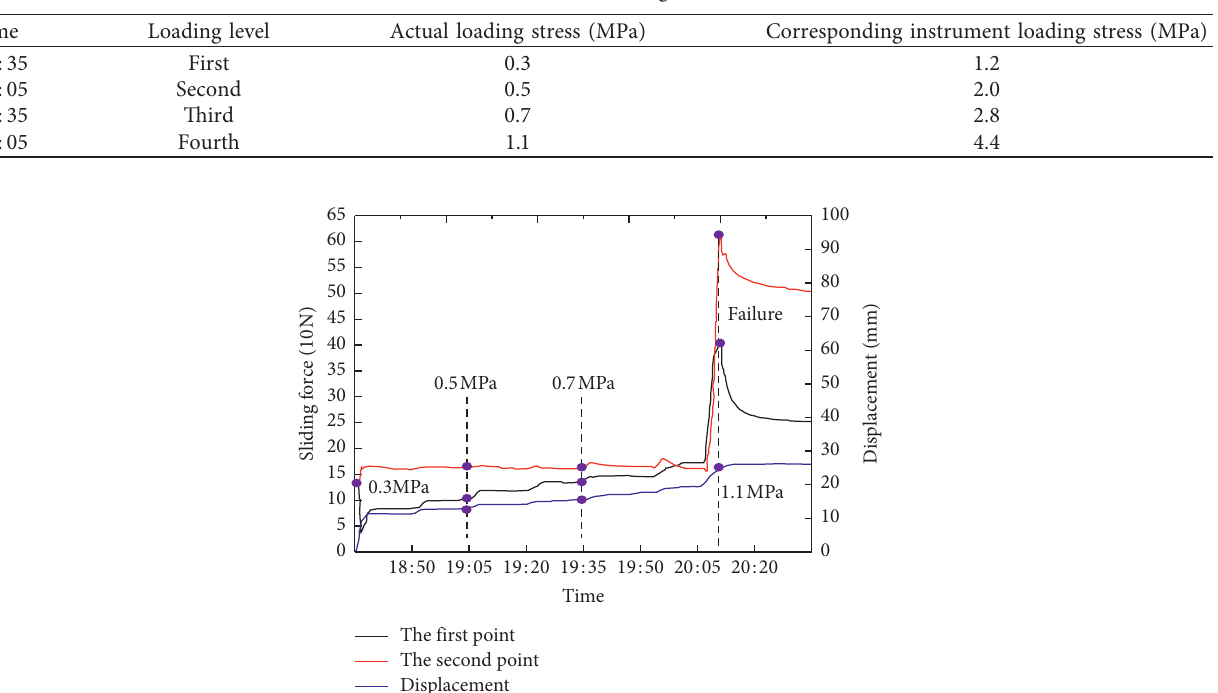
Table 3: Stress loading table.